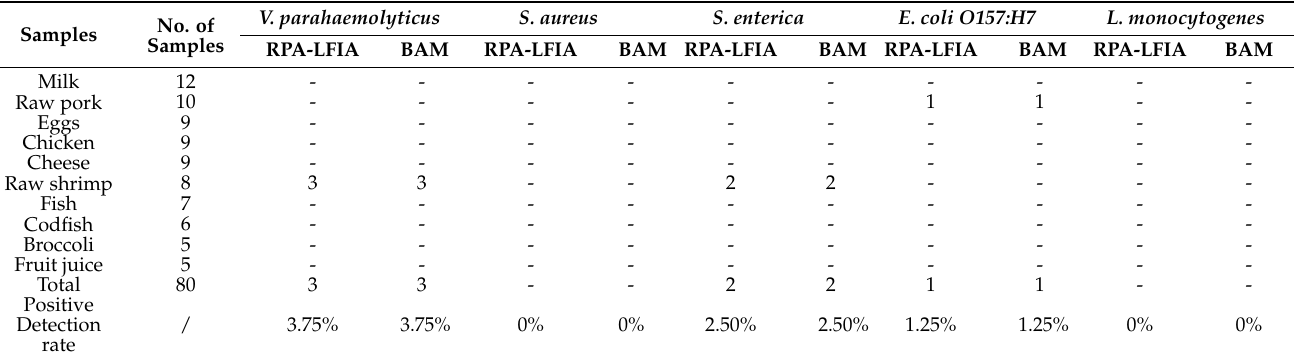
Table 3. Comparison of field samples detected by the RPA-LFIA and BAM